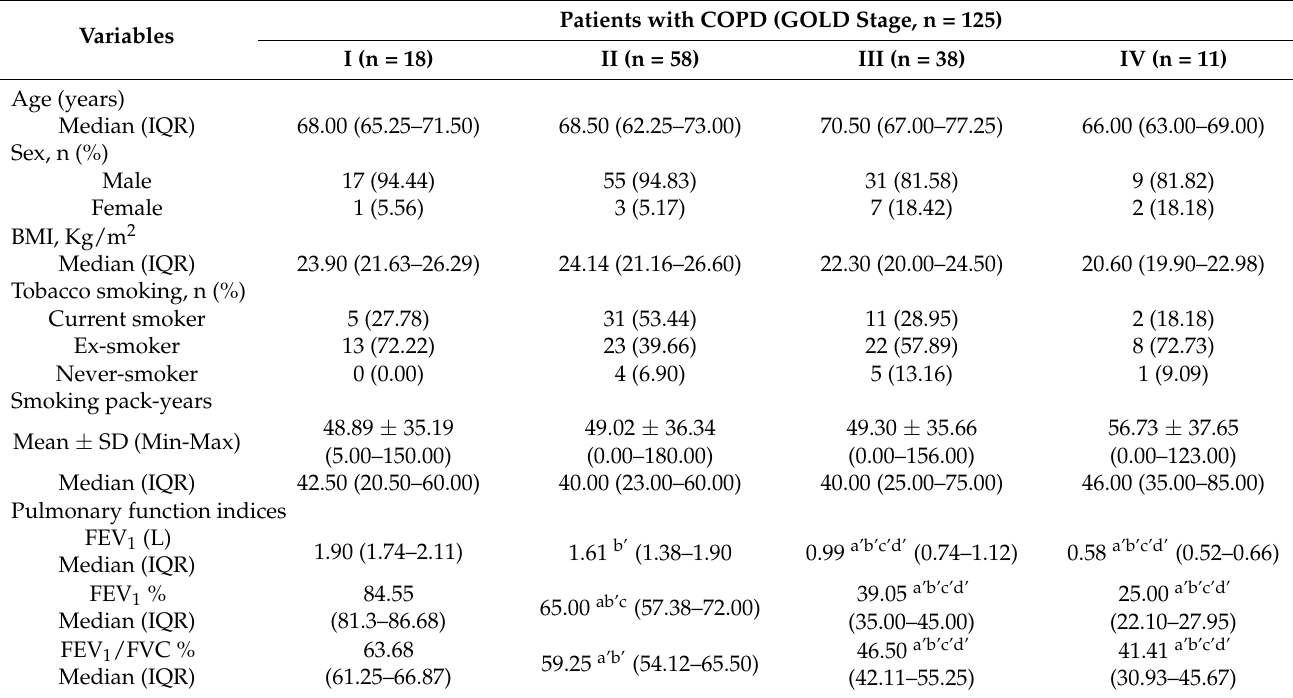
Table 1. Baseline characteristics of our COPD cohort (n =